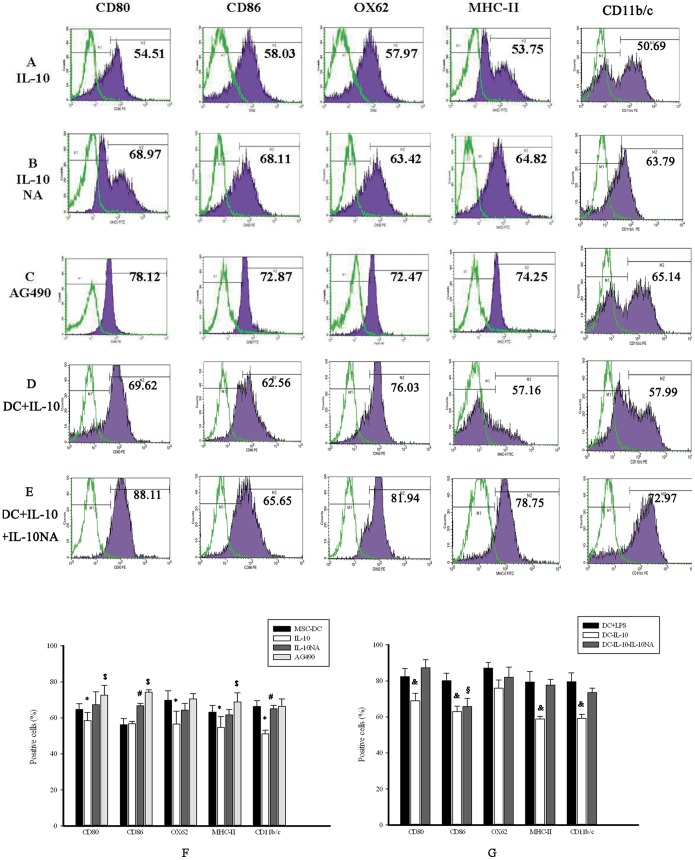
DCs surface markers (CD80, CD86, OX62, MHC-II and CD11b/c) in the MSC-DC co-culture system (ratio MSC:DC of 1∶10) supplemented with exogenous: (A) IL-10; (B) IL-10NA and (C) AG490.(D, E) These makers expression in DC-IL-10 and DC - IL-10 - IL-10NA group by FACS. (F, G) Quantification by image analysis of the positive cells. Numbers in the histograms indicate the mean fluorescence of each DCs markers. *P<0.05(IL-10 group versus MSC-DC group), # P<0.05(IL-10NA group versus MSC-DC group), $ P<0.05(AG490 group versus MSC-DC group).